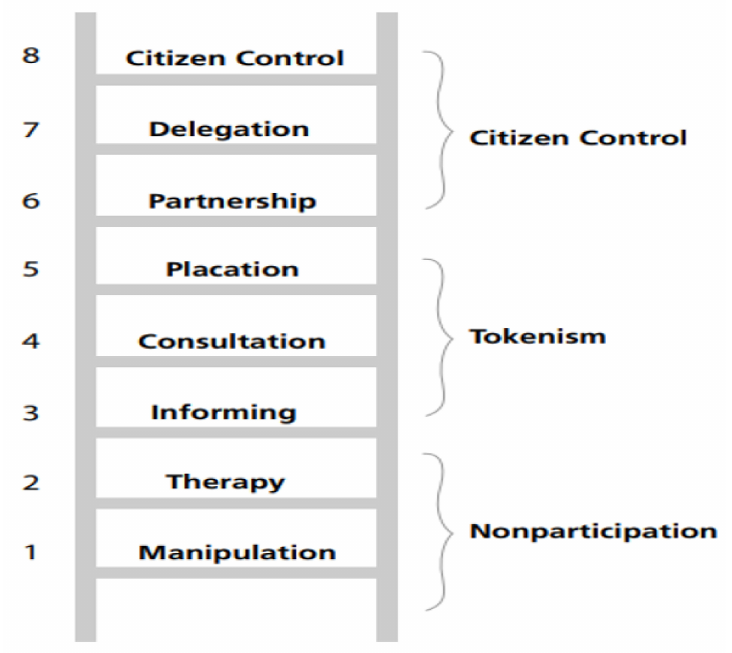
Figure 1. Arnstein’s Ladder of